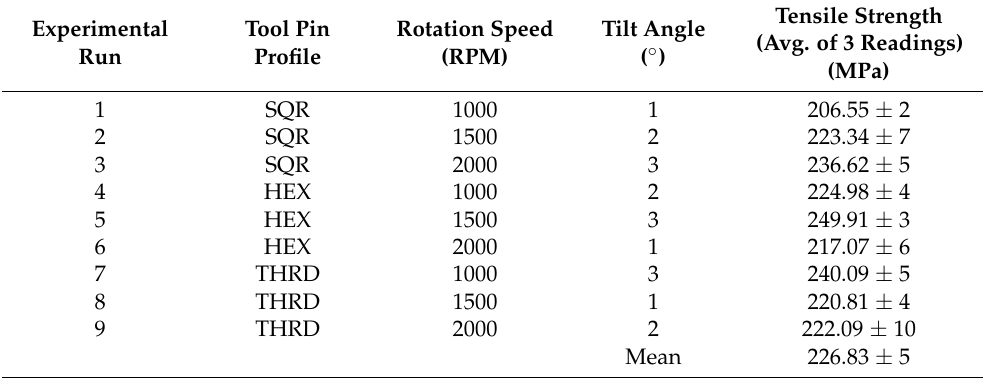
Table 6. Estimated model coefficients for SN ratios.